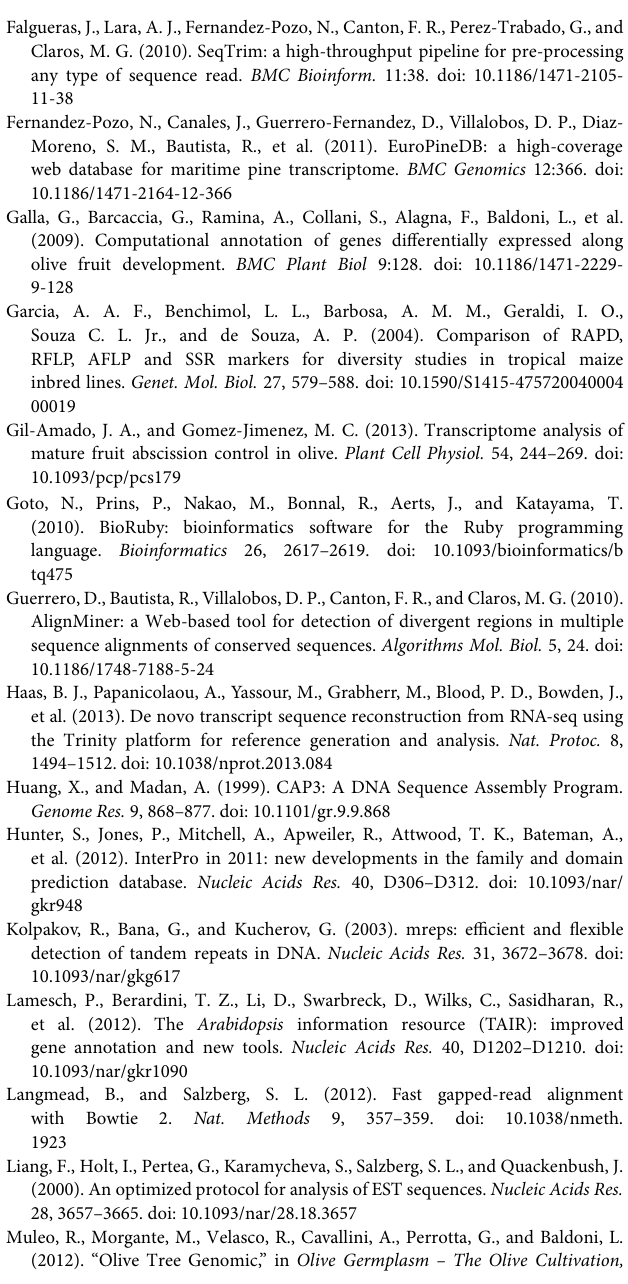
Figure S1 | Flow diagram of the strategy for pre-processing, assembling and annotation of the transcriptomes described in this manuscript, where